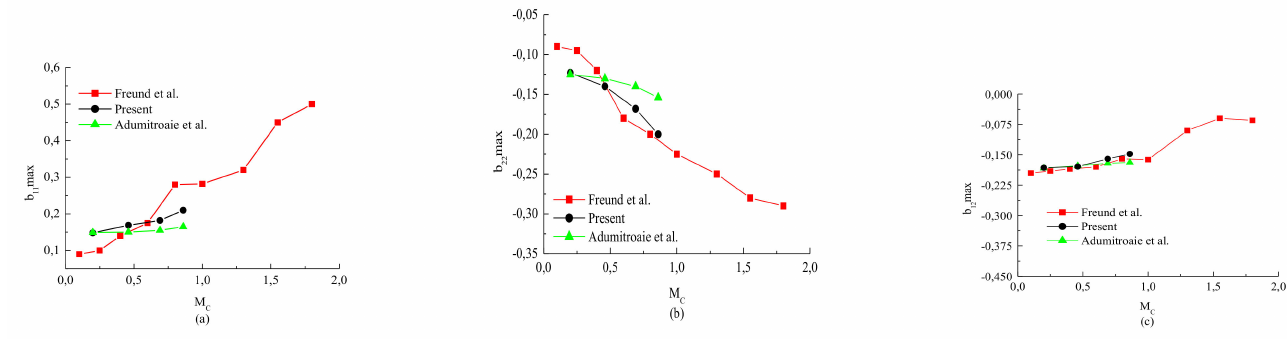
Figure 15. The influence of the convective Mach number on the maximum Reynolds stress anisotropies: ( a ) ( b 11 ) max, ( b ) ( b 22 ) max, and ( c ) ( b 12 )